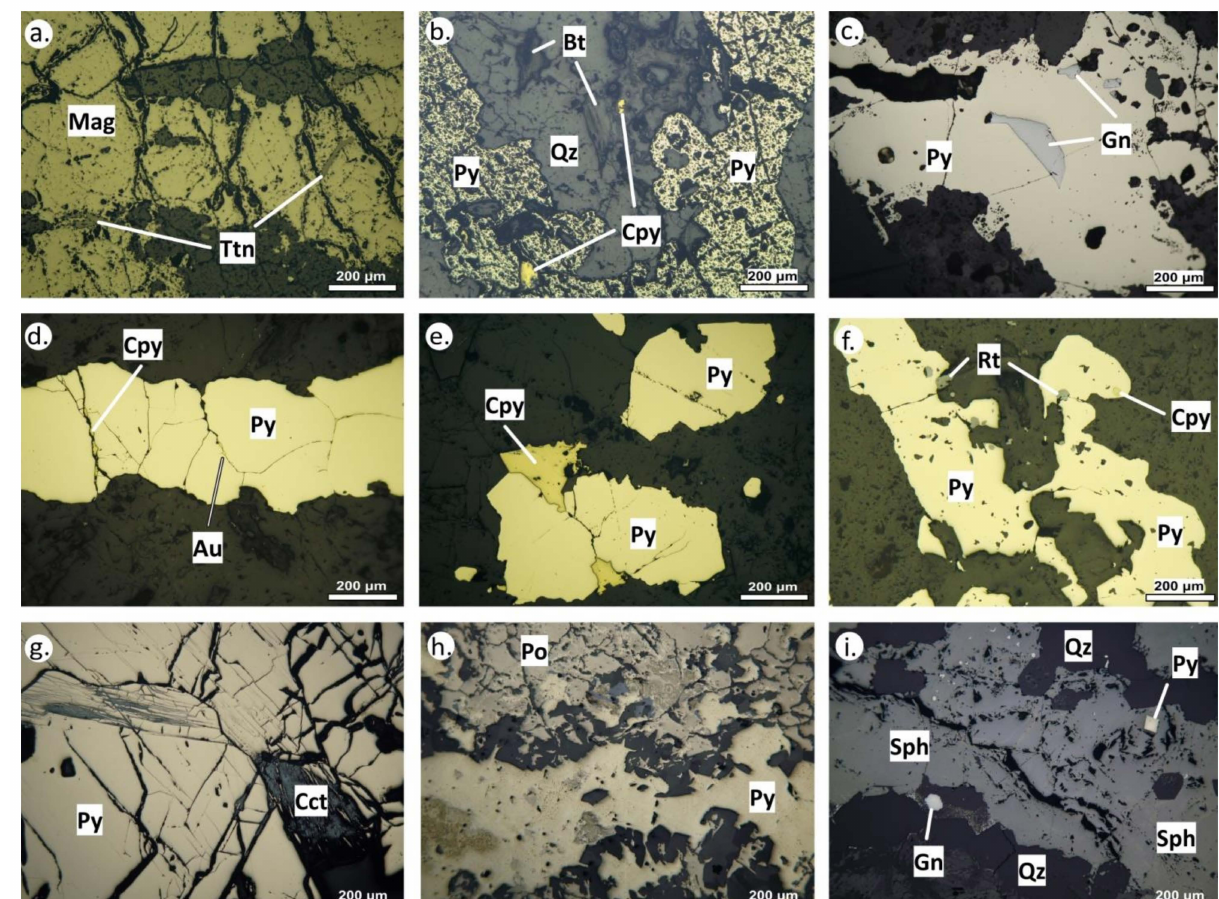
Figure 4. Photomicrographs (plane reflected light) of the hypogene mineralization in quartz monzonite ( a – e ) and latite ( f – i ): ( a ) magnetite (Mag) and titanite (Ttn) in M-type vein from potassic-calcic alteration; ( b ) pyrite (Py), chalcopyrite (Cpy), quartz (Qz), and biotite (Bt) in A-type vein from potassic alteration with sericitic overprint; ( c ) pyrite (Py) in a D-type vein and galena (Gn) filling interstices; disseminated mineralization with pyrite (Py) and galena (Gn) in sericitic alteration; ( d ) pyrite (Py), chalcopyrite (Cpy), and native gold (Au) in D-type vein in sericitic alteration; ( e ) disseminated mineralization with pyrite (Py) and chalcopyrite (Cpy) found in the rock mass around the D-type vein (sericitic alteration); ( f ) pyrite (Py) aggregates with inclusions of chalcopyrite (Cpy) in sericitic alteration; rutile (Rt) is present near the pyrite–host rock contact; ( g ) pyrite (Py) and secondary chalcocite (Cct) in a D-type vein in sericitic alteration; ( h ) pyrrhotite (Po) and pyrite (Py) intergrown in E-type vein (epithermal overprint); ( i ) sphalerite (Sph), galena (Gn), and euhedral pyrite (Py) in E-type vein rimmed by quartz (Qz) (epithermal